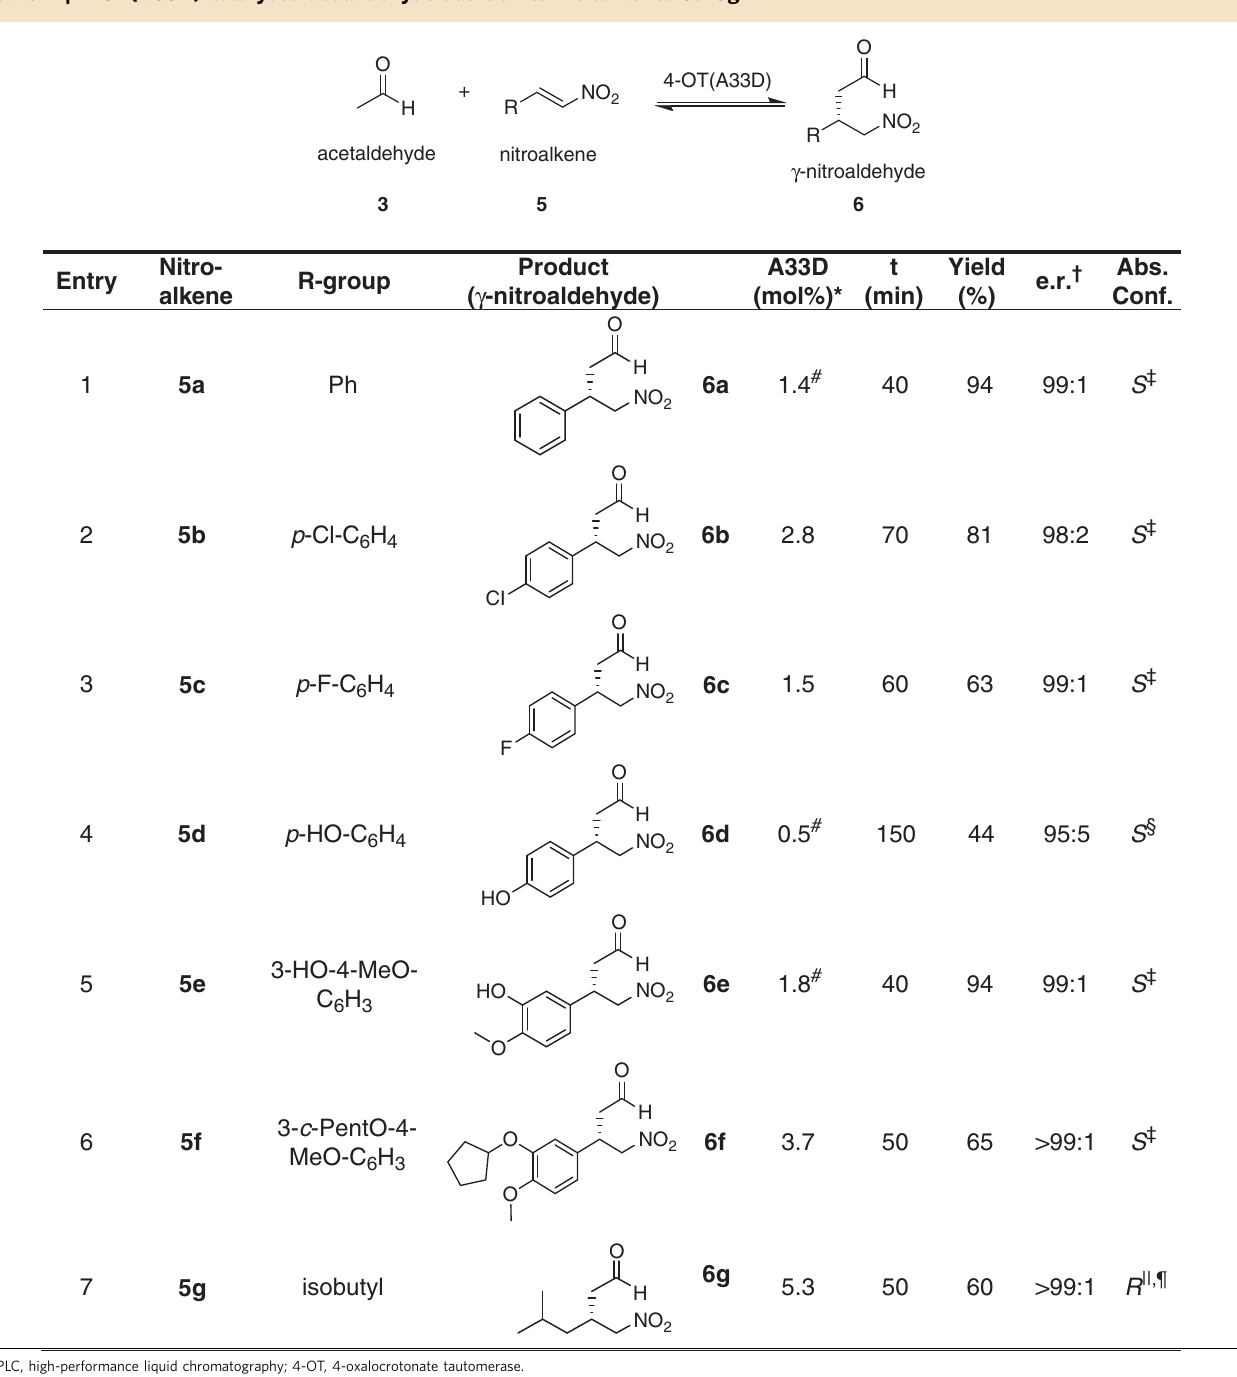
Table 2 | 4-OT(A33D)-catalysed acetaldehyde addition to nitroalkenes